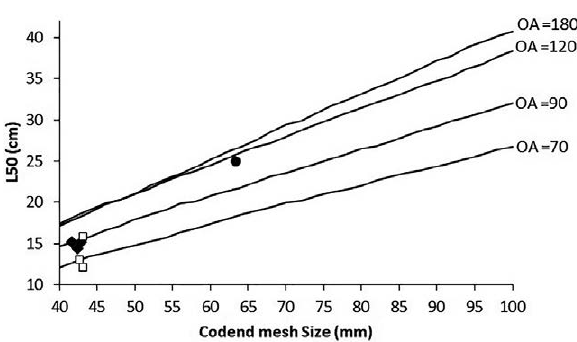
Fig. 6. – Predicted L50 values for square mesh codends for mesh sizes between 40 and 100 mm and opening angles between 70° and 180° (FISHSELECT 100% open) (solid lines) and previously pub- lished experimental L50 data (black diamonds represent Turkish experimental results, white squares Italian ones and black circles Portuguese ones) (Table